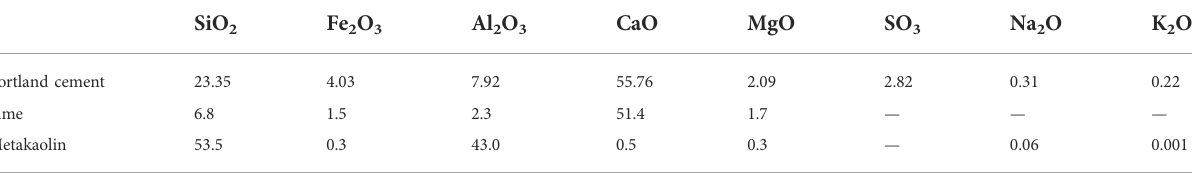
TABLE 2 Chemical compositions of cement, lime, and metakaolin (%).